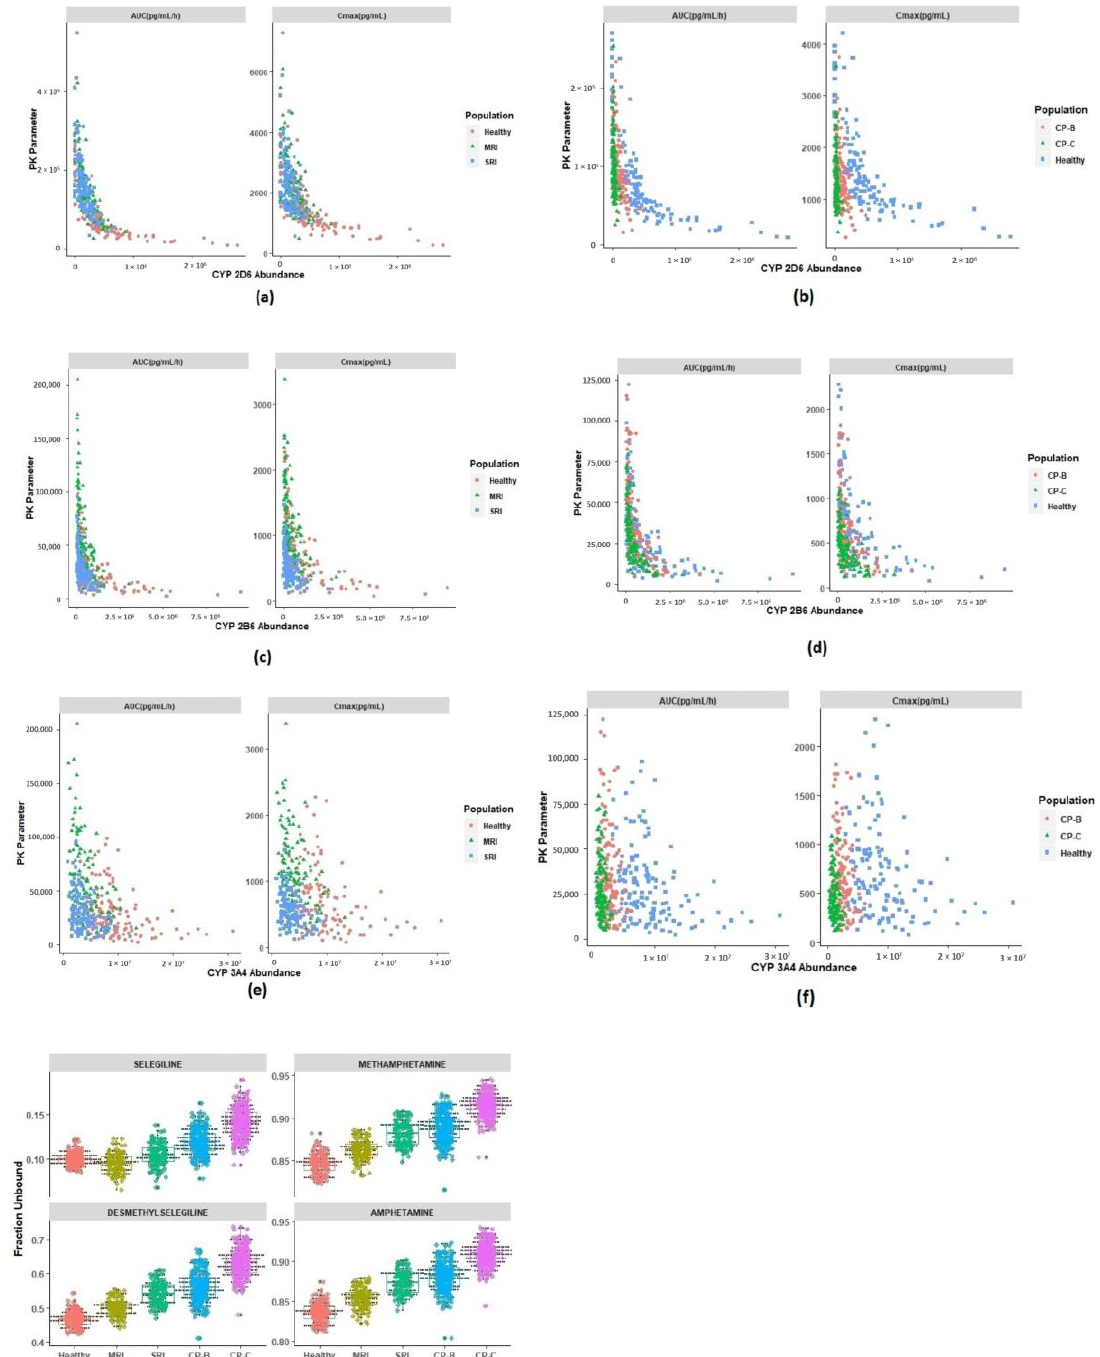
Figure 7. Potential physiological covariates that are responsible for disposition discrepancies between healthy and special populations. MRI: moderate renal impairment, SRI: Severe renal impairment, CP-B: Child Pugh-B hepatic cirrhosis, CP-C: Child Pugh-C hepatic cirrhosis. ( a ) PK parameters of Methamphetamine versus CYP 2D6 abundance (pmol / mg protein) in renal impairment subjects. ( b ) PK parameters of Methamphetamine versus CYP 2D6 abundance (pmol / mg protein) in hepatic cirrhosis subjects. ( c ) PK parameters of Desmethyl selegiline versus CYP 2B6 abundance (pmol / mg protein) in renal impairment subjects. ( d ) PK parameters of Desmethyl selegiline versus CYP 2B6 abundance (pmol / mg protein) in hepatic cirrhosis subjects. ( e ) PK parameters of Desmethyl selegiline versus CYP 3A4 abundance (pmol / mg protein) in renal impairment subjects. ( f ) PK parameters of Desmethyl selegiline versus CYP 3A4 abundance (pmol / mg protein) in hepatic cirrhosis subjects. ( g ) Fraction unbound plasma in di ff erent simulated populations.